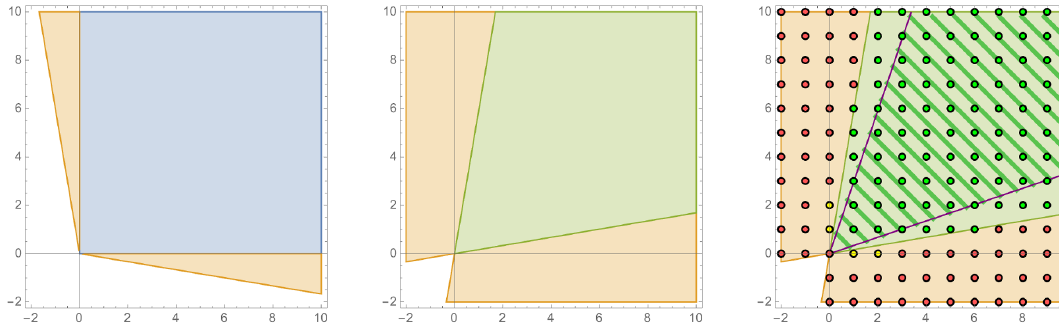
Figure 2 . Kähler and Mori cone for CICY 7863. Left : Kähler cone K (blue) of X and the extended Kähler cone K ext (blue and orange). Center : the (dual) Mori cone M of K (blue and green) and the union of all Mori cones M 0 of K 0 (orange, blue, green).The restricted cone is M restr = M ∩ M 0 (green). Right : we included GV invariants. Green dots indicate non-zero GV invariants, red dots indicate zero GV invariants, and yellow dots indicate (non-zero) GV invariants in curve classes that are flopped. A choice for the fundamental cone M f ⊂ M restr is the hatched region between the two purple